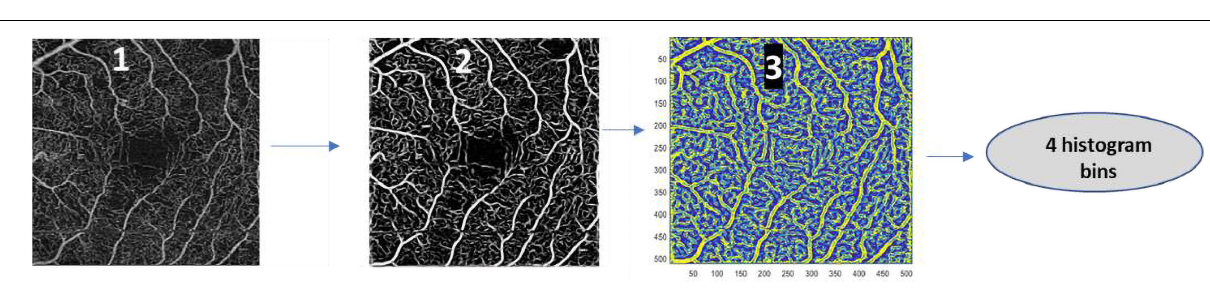
FIGURE 3 | Steps done for the computation of the number of pixels assigned to each scale generated during the process of applying a Frangi Filter to the en-face image (histogram bins). Image 1 corresponds to the en-face slab image, image 2 corresponds to the enhanced vessel slab using the Frangi Filter, and image 3 corresponds to the matrix, resulting from the process of filtering the en-face slab with the Frangi Filter with four scales, with the scales on which the maximum intensity of every pixel is found.